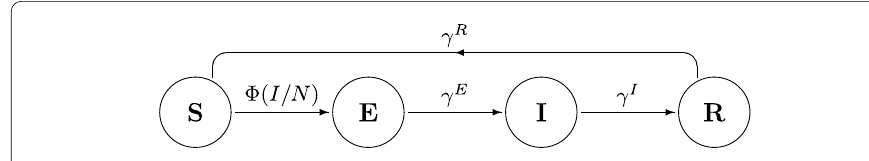
Figure 1 Disease flowchart of SEIRS epidemic model (4)